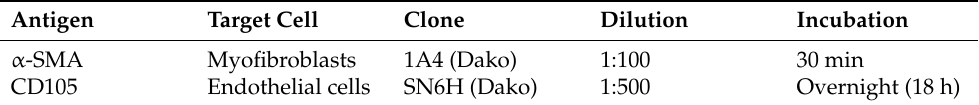
Table 2. Target antigens and antibodies used in the immunohistochemical analysis of myofibroblast differentiation (MFd) and microvascular density